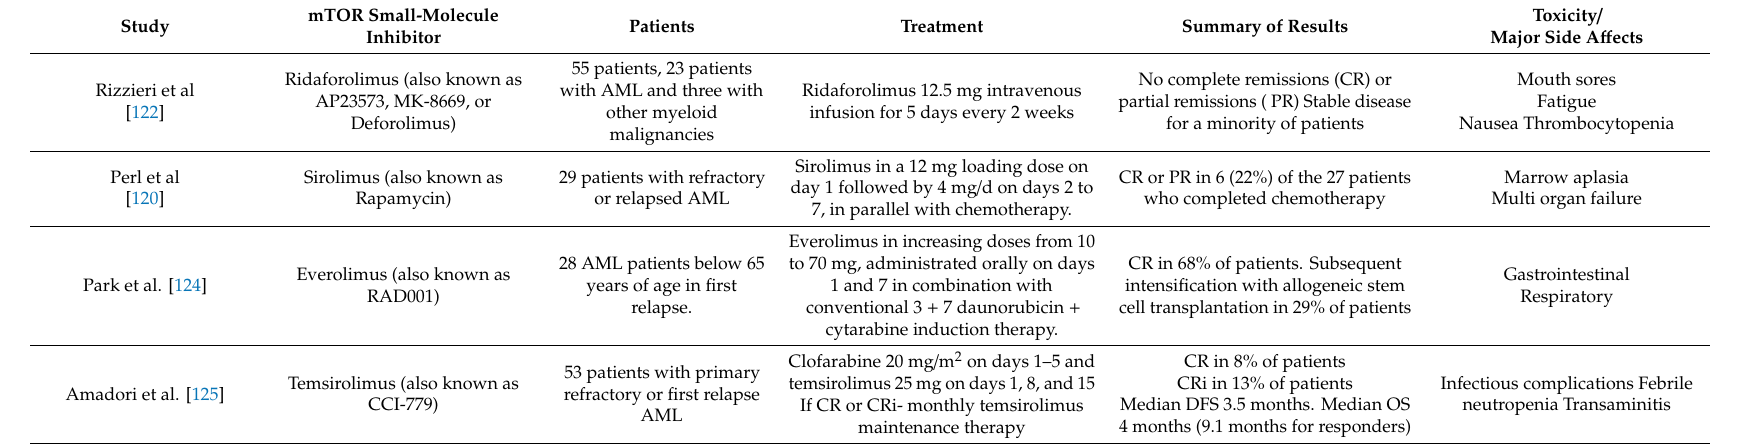
Table 1. Important clinical studies with mTOR inhibitors. The table summarizes the most important findings in larger studies ( > 20 patients included) using mTOR inhibitors either alone or in combination with other chemotherapy regimens for AML patients. The abbreviations shown in the table can be found in the list of